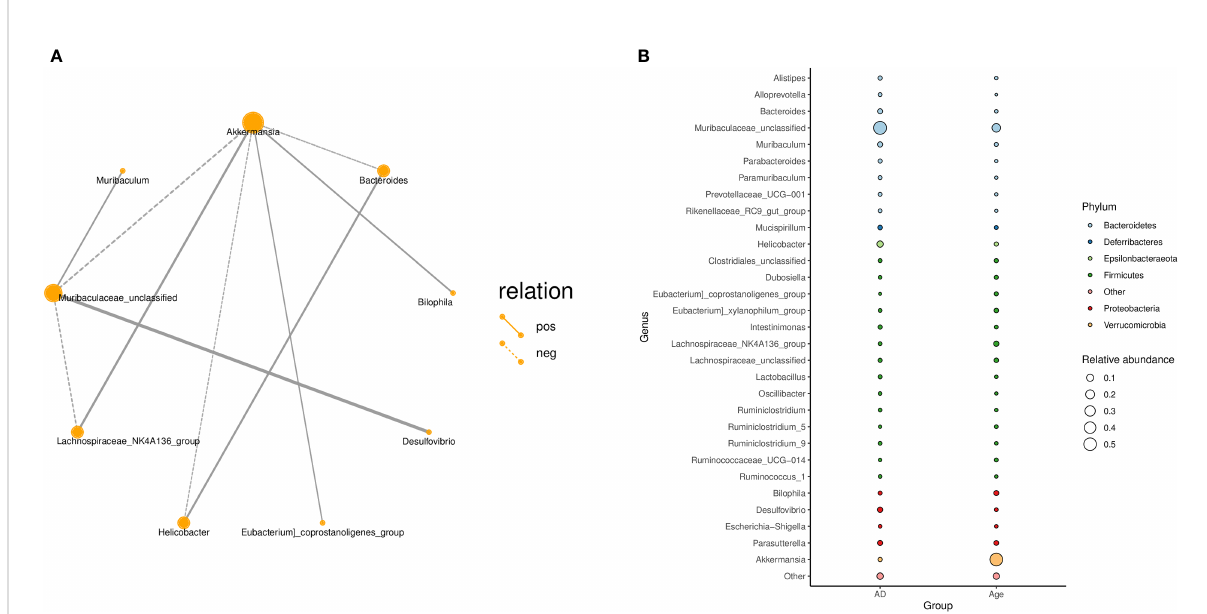
FIGURE 4 (A) Correlation network diagram: Different nodes in the network diagram represent different dominant genera. The connection between nodes indicates that there is a correlation between the two genera. By default, we show the relationship pair of correlation coef fi cientsRho> 0.4. (B) Bubble plot: The species annotation information and relative abundance (circle size) at the genus level in various sample groups as well as the species annotation information (circle colour) of the species-corresponding